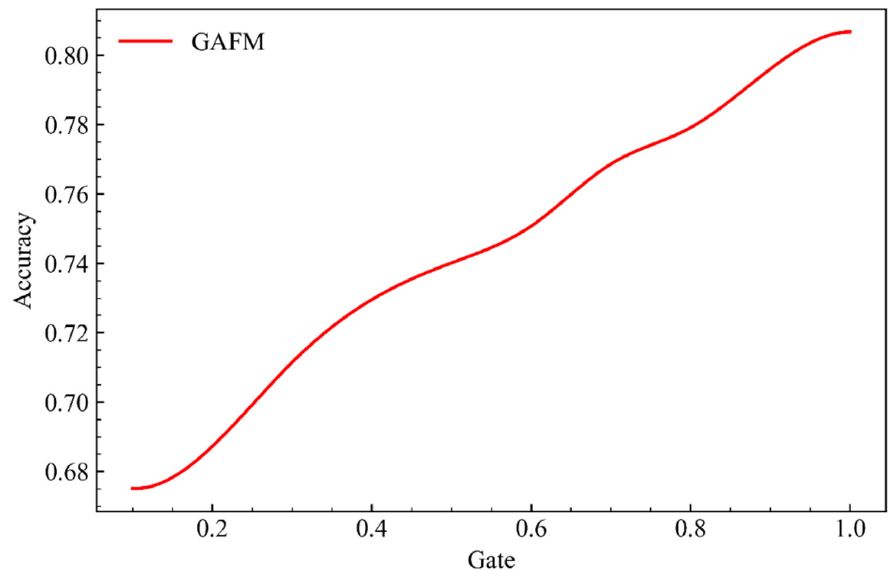
Figure 7. Prediction accuracy of GAFM under the influence of g.